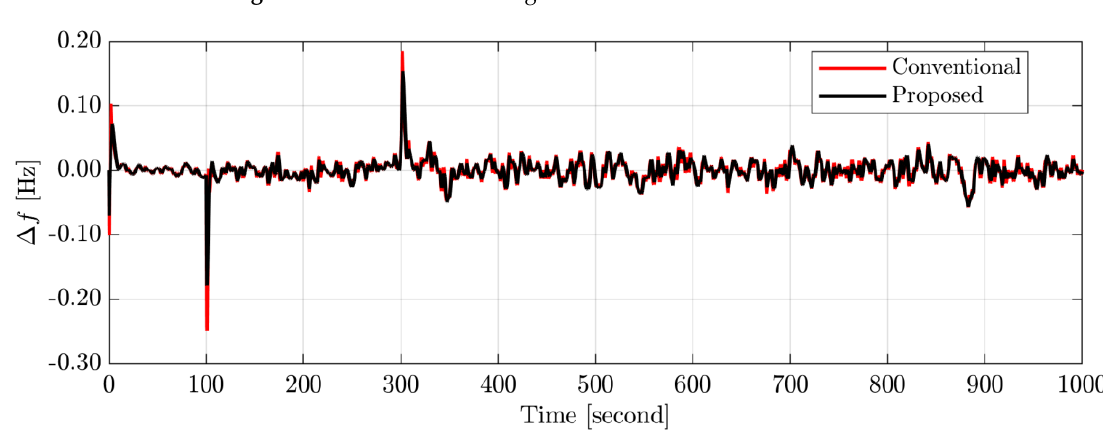
Figure 16. System frequency deviation of the studied µG for the case 3.